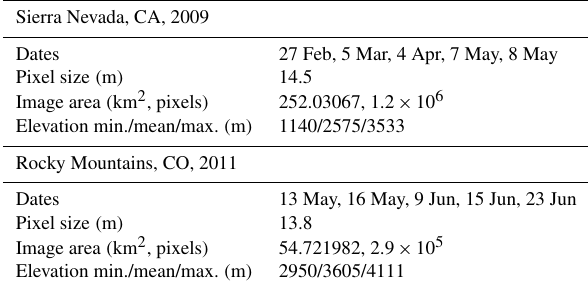
Table 1. Data parameters of the study areas derived as a mosaic from the subsets of flight lines (see Table 2 and Fig. 1).